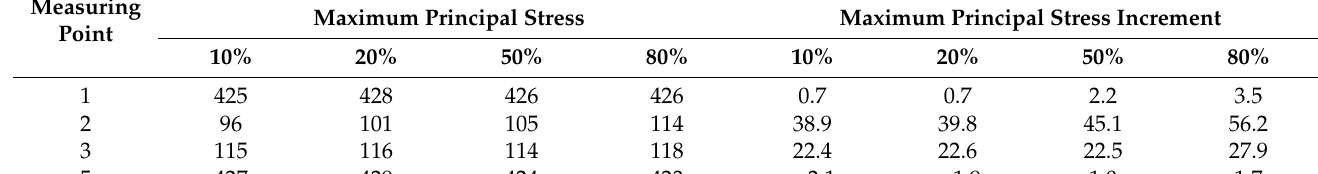
Table 17. Maximum principal stress amplitude of measuring points 1, 2, 3, and 5 under different degrees of damage to the basement structure.